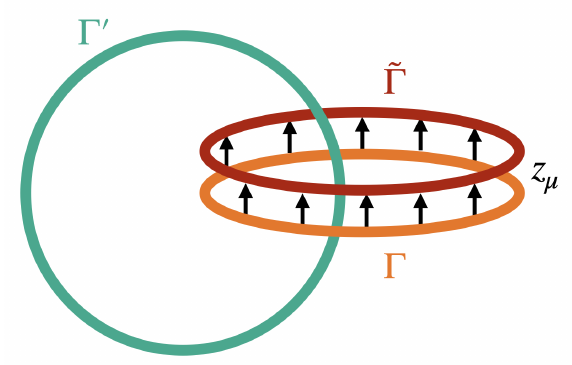
Figure 6 . The non local operator O Γ is defined with the curve Γ . In the complementary region we have O Γ 0 , defined with Γ 0 , that does not commute with O Γ . The curve ˜Γ is obtained when acting with small translations z µ over Γ . The translation changes the non local classes for the graviton. However, to the operator of a specific class in ˜Γ it corresponds an operator with the same class in Γ not by translating it, but by extending the surface integral from ˜Γ to Γ with local